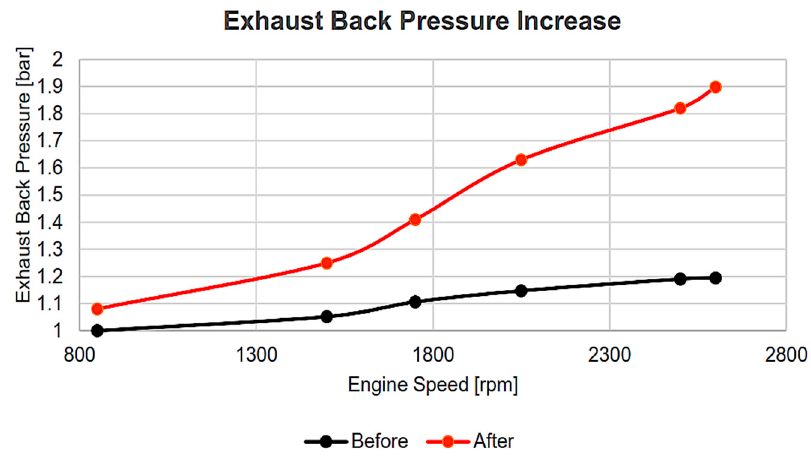
Figure 17. T / C system backpressure Figure 17. T/C system backpressure increment.